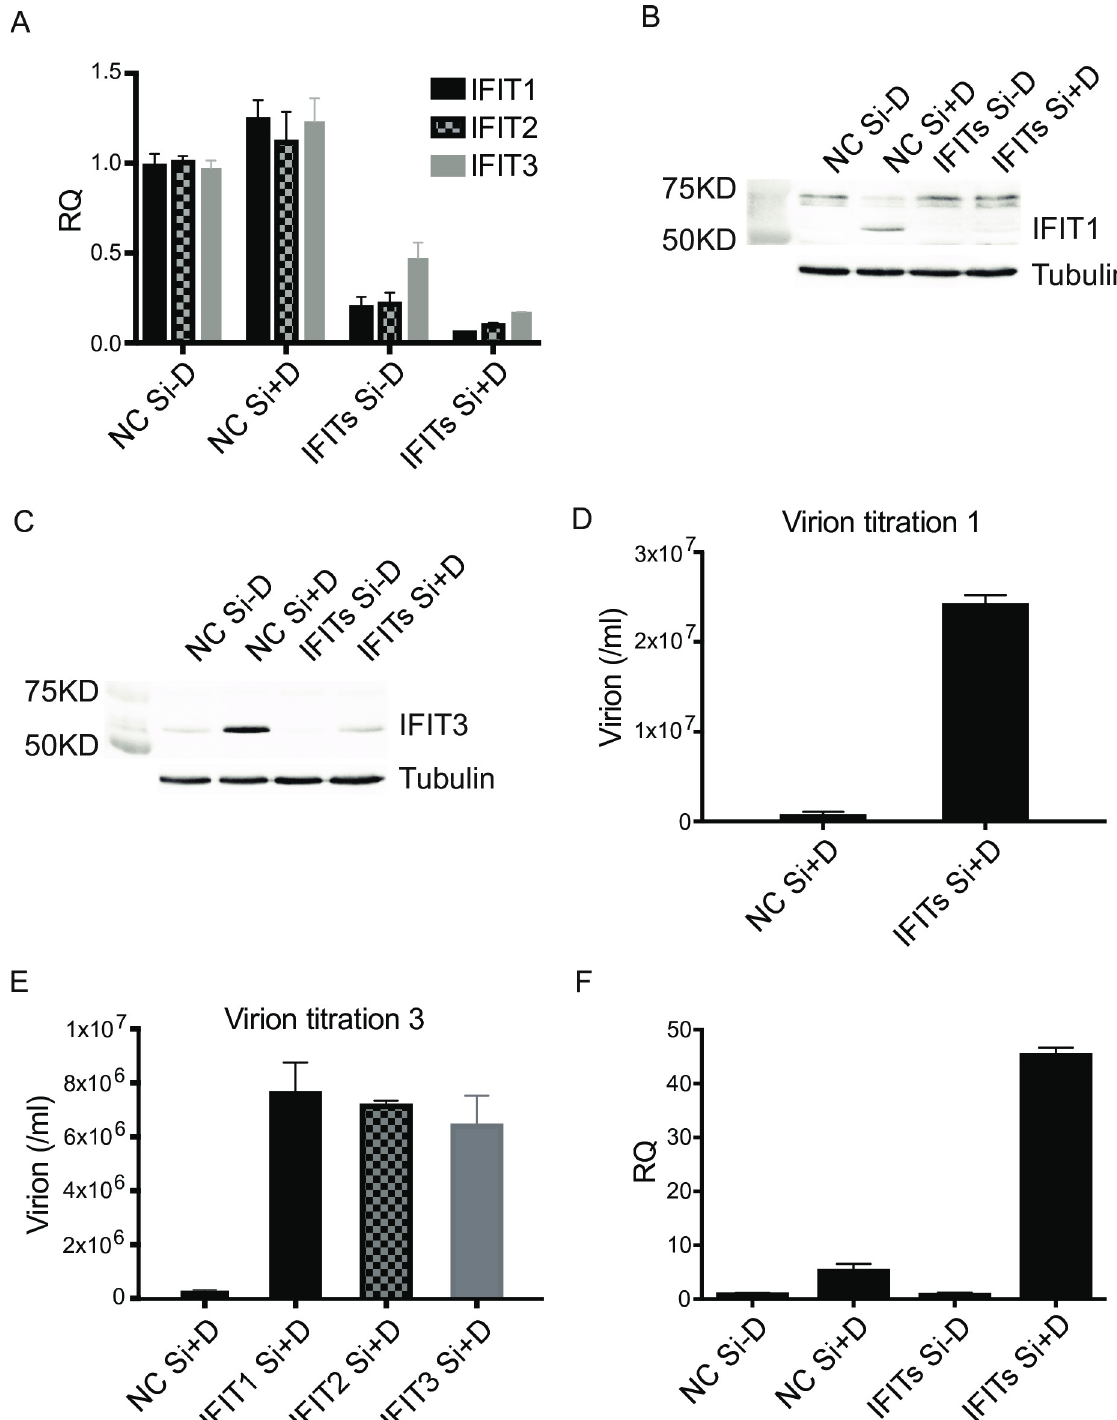
Fig 3. KSHV virus production in cells depleted of IFIT1, IFIT2 and IFIT3. A. Effect of IFIT KD on IFIT1, IFIT2 and IFIT3 mRNA levels. IFIT and negative control KDs were performed in iSLK cells and RNA was isolated from cell pellets 48 hr after induction of replication. IFIT1, IFIT2 and IFIT3 mRNA expression was measured by qPCR. Cells were either untreated (-D) or treated with doxycycline (+D) to induce replication. RQ (relative quantity). Each experiment was performed with biological triplicates and technical triplicates. Error bars show SEM of qPCR from triplicate samples. B, C. Effect of IFIT KD on IFIT protein levels. Immunoblotting of lysates from cells used in panel A above was performed with anti-IFIT1 and anti-IFIT3 antibodies to verify completeness of IFIT1 and IFIT3 depletion. Lysates were